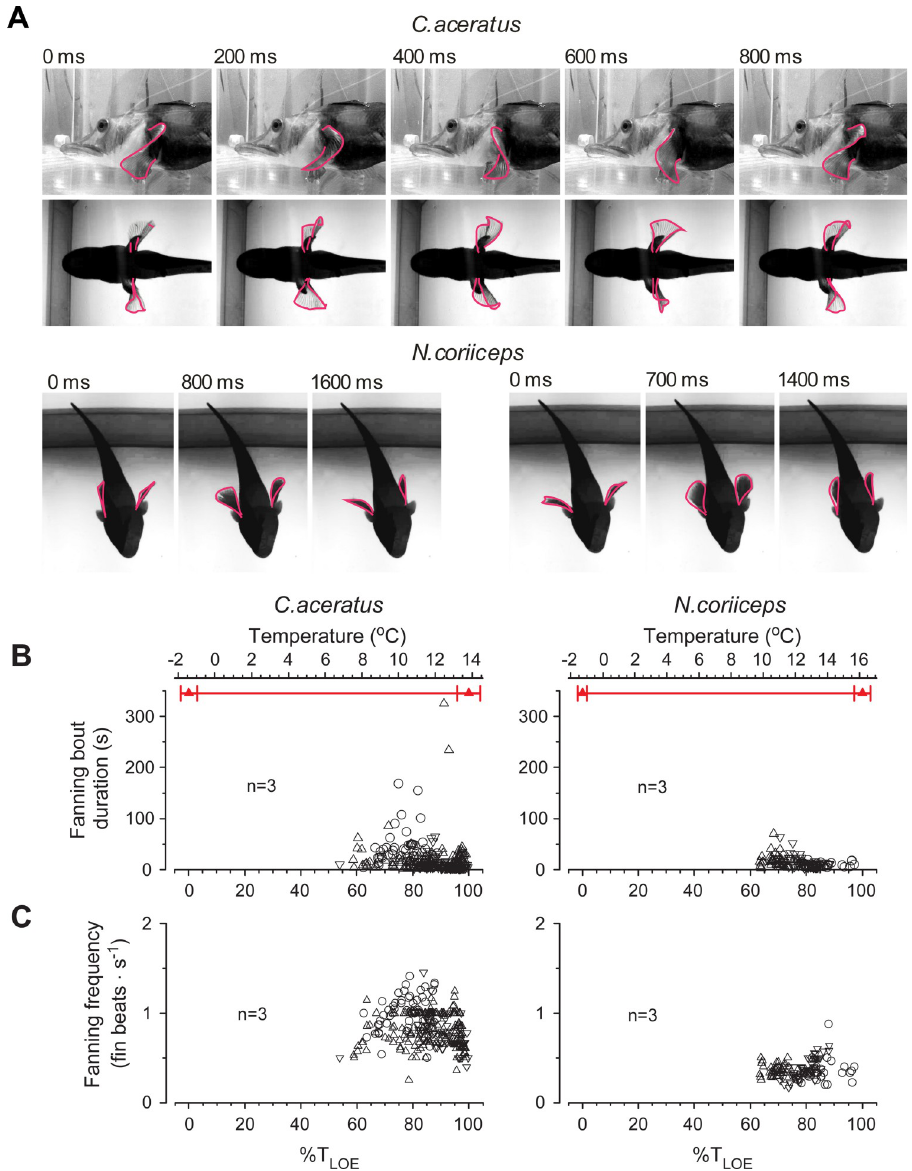
Fig 6. Acute warming elicits pectoral fin fanning in Hb- C . aceratus and Hb+ N . coriiceps . (A) Top panel depicts lateral (upper images) and ventral (lower images) view of one complete cycle (800 ms in duration, every 6th frame shown) of undulatory fanning, typical for C . aceratus . Bottom panel depicts ventral view of one cycle of “sway” (fins adducted and abducted in a counterphase) fanning 1.6 s in duration (left set of images, every 24th frame is shown) and one cycle of “sweep” (fins adducted and abducted in a synphase) fanning 1.4 seconds in duration (right set of images, every 21st frame is shown), characteristic for N . coriiceps . (B) Temperature plots of duration of fanning bouts (episodes of uninterrupted continuous fanning at near constant frequency). (C) Temperature plots of fanning frequency (number of fin beats per second within a bout). For conventions of quantification and presentation of grouped data as a function of temperature, see Materials and Methods. Different symbols in (B) and (C) represent three specimens of each